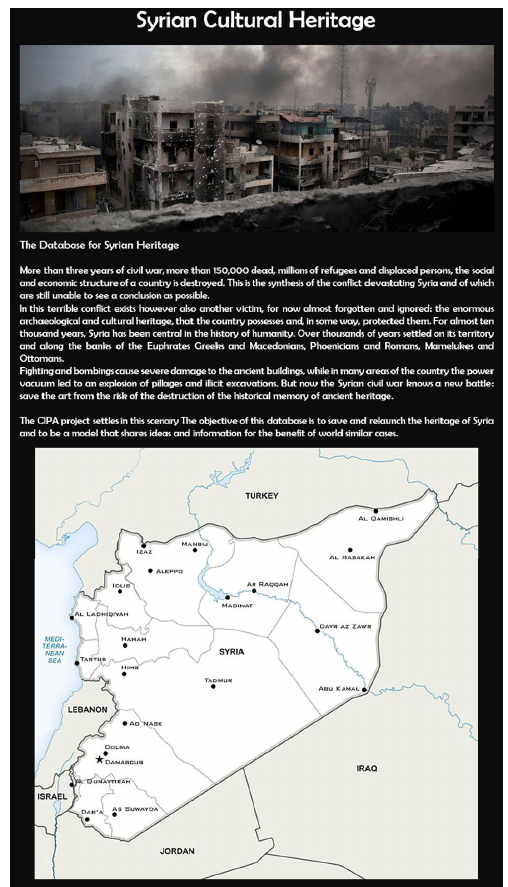
Figure 3. Primary data classifications